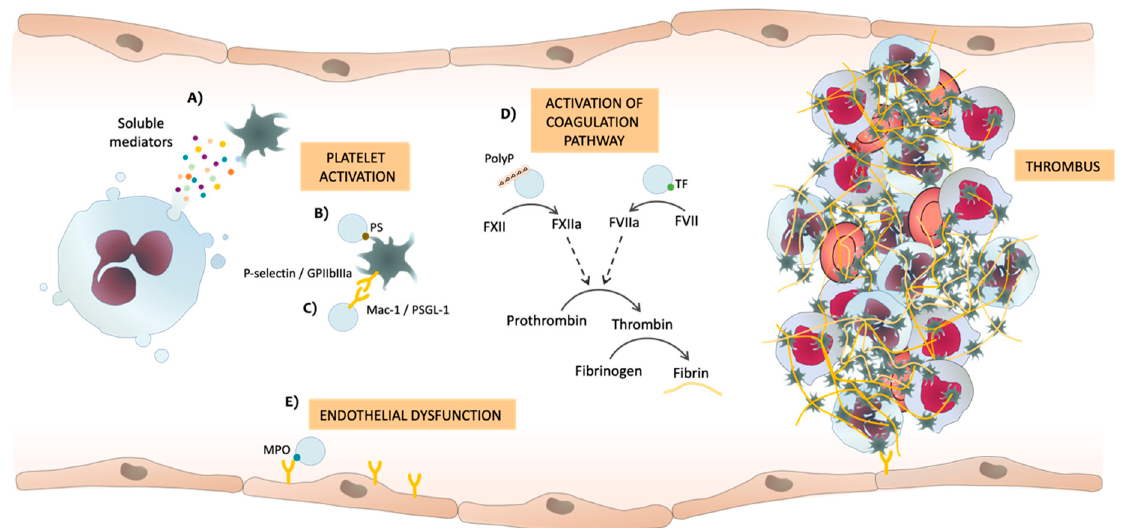
Figure 2. Potential mechanisms by which soluble mediators or neutrophil extracellular vesicles (EVs) released by neutrophils can induce thrombosis. ( A ) Soluble mediators released by neutrophils, ( B ) phosphatidylserine (PS) and ( C ) different adhesion molecules present in the membrane of EVs interact with platelets, thereby inducing platelet activation and aggregation. ( D ) EVs activate both intrinsic and extrinsic coagulation pathways. Polyphosphates (PolyP) and tissue factor (TF) in EVs can activate the coagulation cascade, thus producing thrombin from its inactive form of pro-thrombin, and thrombin finally induces the formation of fibrin from fibrinogen. ( E ) Myeloperoxidase (MPO) in EVs can induce endothelial dysfunction, which triggers platelet activation and aggregation. F: factor; GP: glycoprotein; PSGL-1: P-selectin glycoprotein ligand-1.